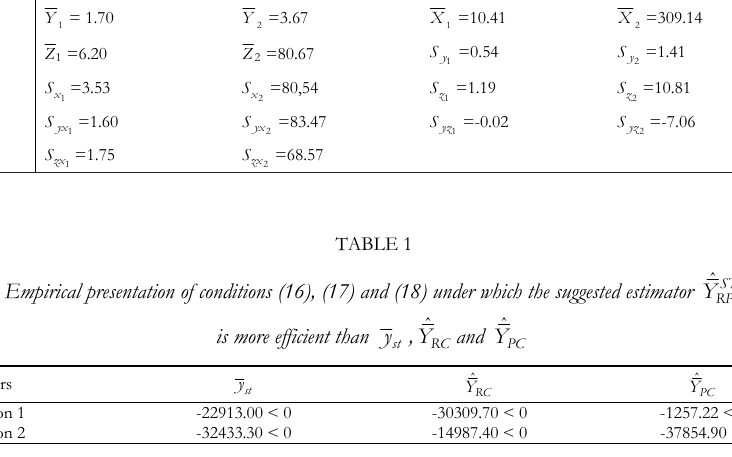
ˆ ˆ y , Y , Y st RC PC